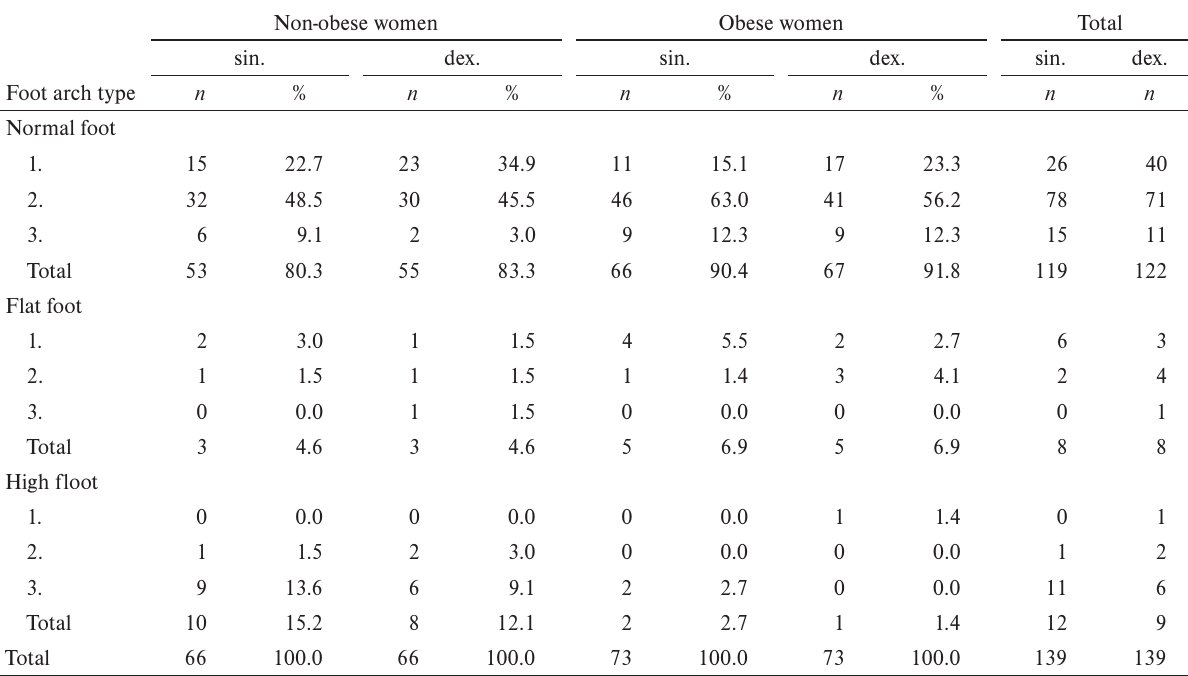
Frequency of foot arch types in non-obese and obese women